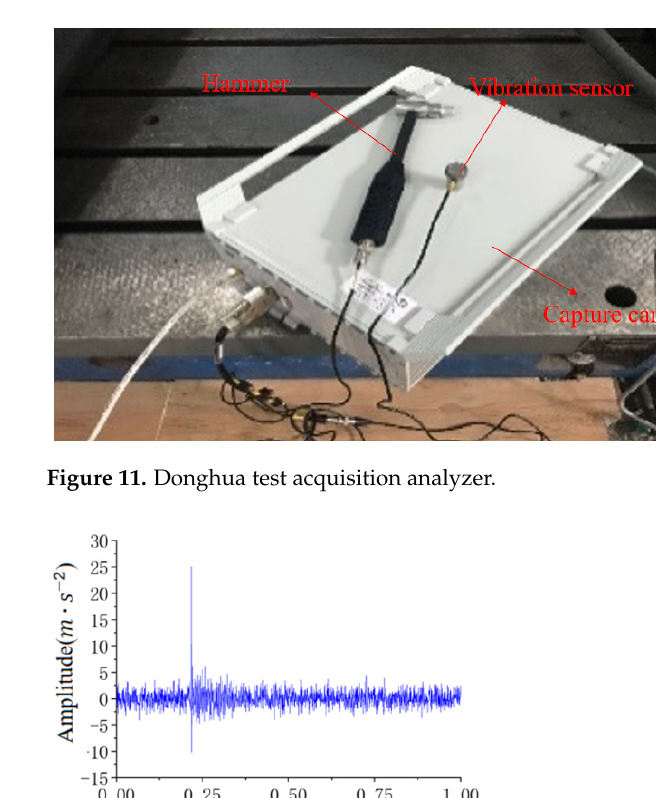
Figure 14. Sparse decomposition simulation amplitude/envelope results. ( a ) sparse decomposition amplitude map, and ( b ) sparse decomposition envelope spectrum. 5. Recognition and Analysis of Gas Turbine Rotor System Impact Load Signals A new vibration and shock sparse identification method, based on MC penalty func ‐ tion sparse decomposition vibration and shock signal identification method, is proposed. This method can not only separate the shock components in the early fault signal of the gas turbine rotor system, but also effectively suppress the impact of noise on the sparse decomposition process. Interference has a good noise reduction effect, and better pre ‐ serves high ‐ amplitude amplitude components [36,37]. In order to further verify the adaptability of the method, the basic parameters of the test bench of a certain type of gas turbine rotor system are as follows: working speed of 9000 rpm, sensor test records the frequency of high ‐ pressure shaft rotation, sampling fre ‐ quency f_s is 6000 Hz, and the operating speed is kept at 0.1 working condition (about 7462 rpm). The structure of a certain type of gas turbine rotor system is shown in Figure 15. During the test, the speed is slowly increased from low speed to the 0.1 condition, and the sensor detects that the amplitude of the rotor bearing at the rear point obviously in ‐ creases. The vibration signal is recorded by the INTEDER data acquisition and analyzer of Yiheng. The acquisition channel is 16 channels. The time domain diagram of the signal collected by the acquisition equipment after data compression and analysis processing is shown in Figure 16.